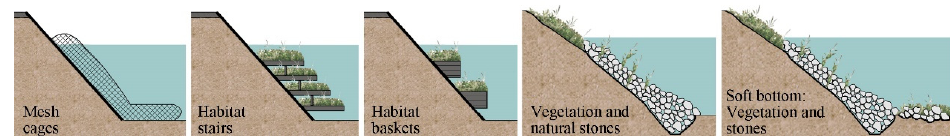
Figure 9. Shoreline forms to enhance